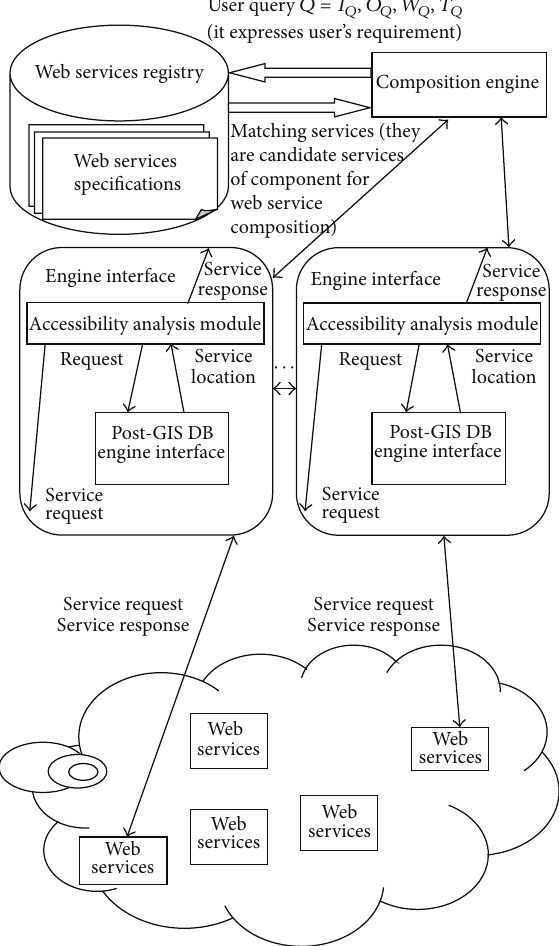
Figure 1: Execution framework